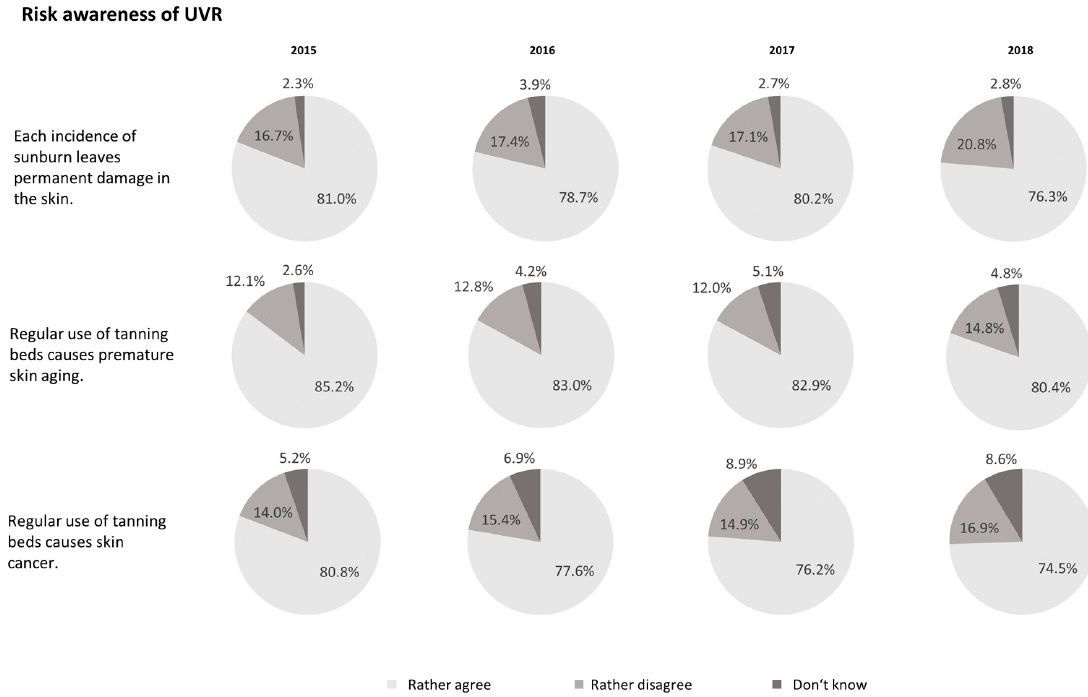
Figure 3. Risk awareness regarding ultraviolet radiation and tanning bed use from 2015 to 2018. Data are based on the waves 2015, 2016, 2017, and 2018 of the National Cancer Aid Monitoring (NCAM). Data are weighted by sex, age, and education to be representative for Germany. n = 3000 individuals aged 14 to 45 years (per wave).